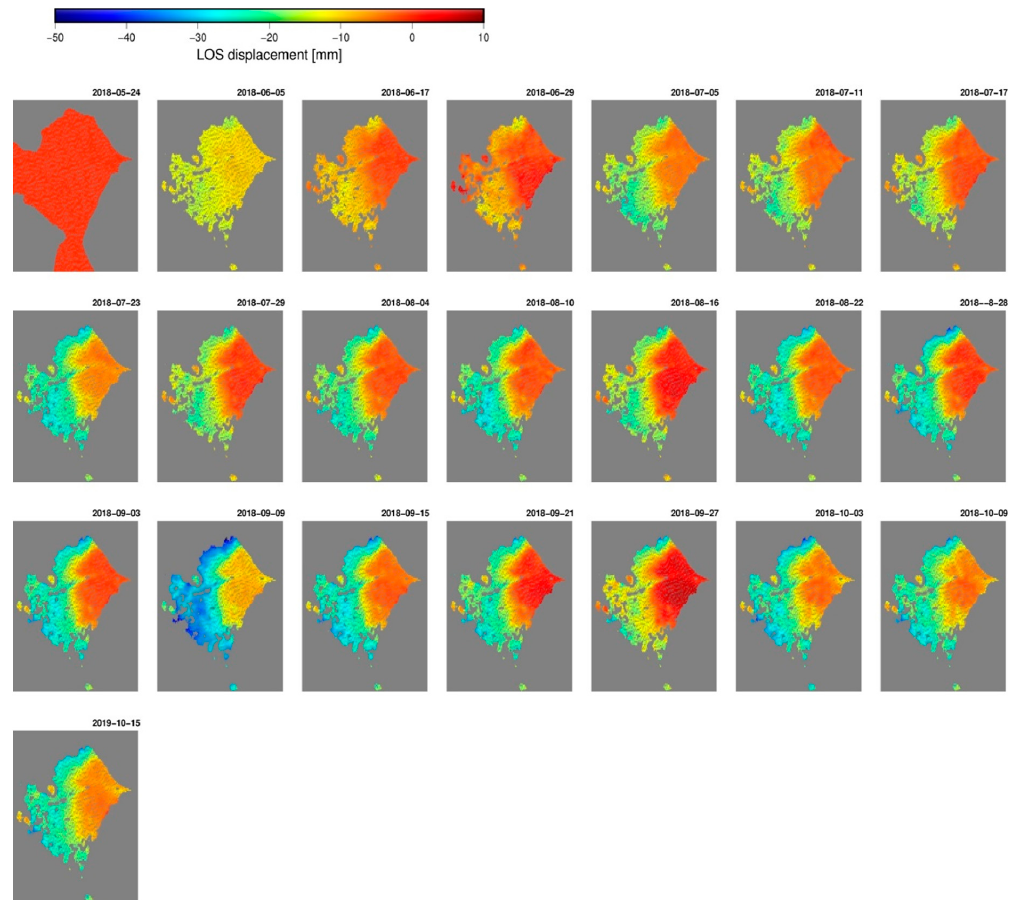
Figure A3. Time series for track 14 for the Elveflya outwash fan. All LOS displacements in each of the time periods. The reference time period is 24 May.